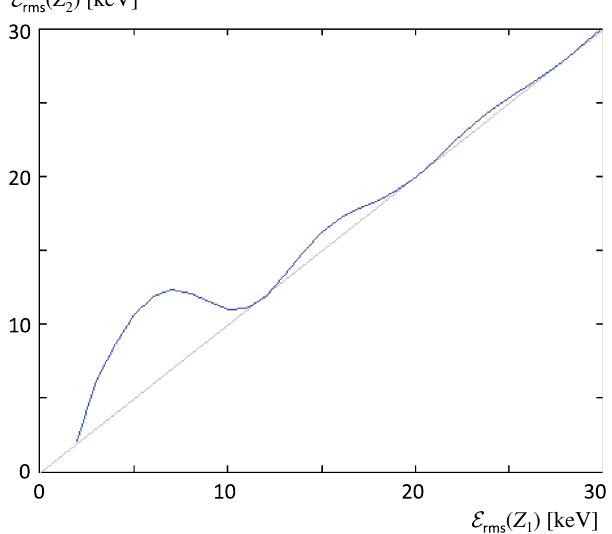
FIG. 23. Application C: energy spread at the spectrometer (position Z 2 ¼ 19 m) as function of the spread directly after the laser heater chicane (position Z 1 ¼ 11 m). The initial spread varies due to different laser